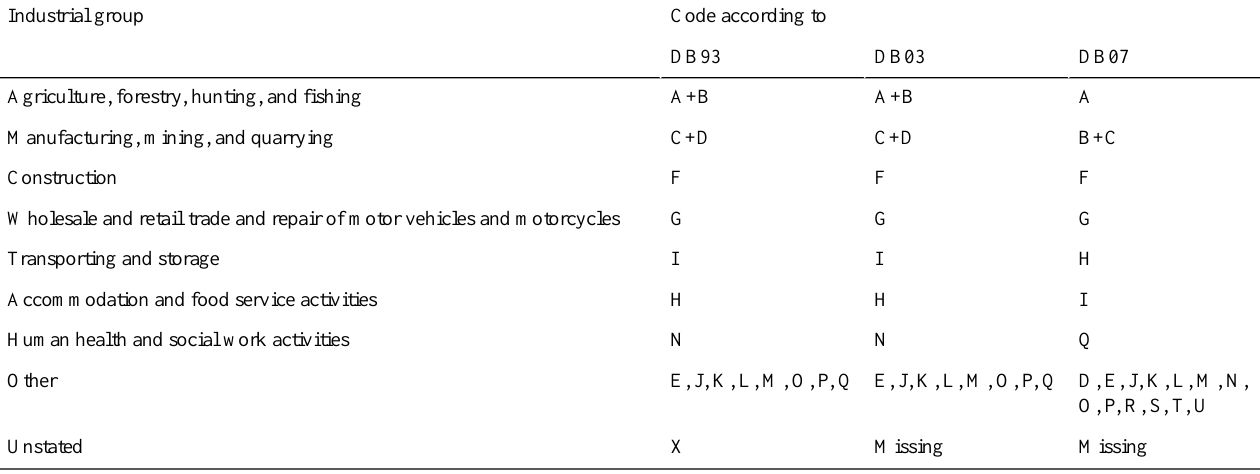
Table 3. Industrial groups coded according to the classifications DB93, DB03, and DB07, respectively.